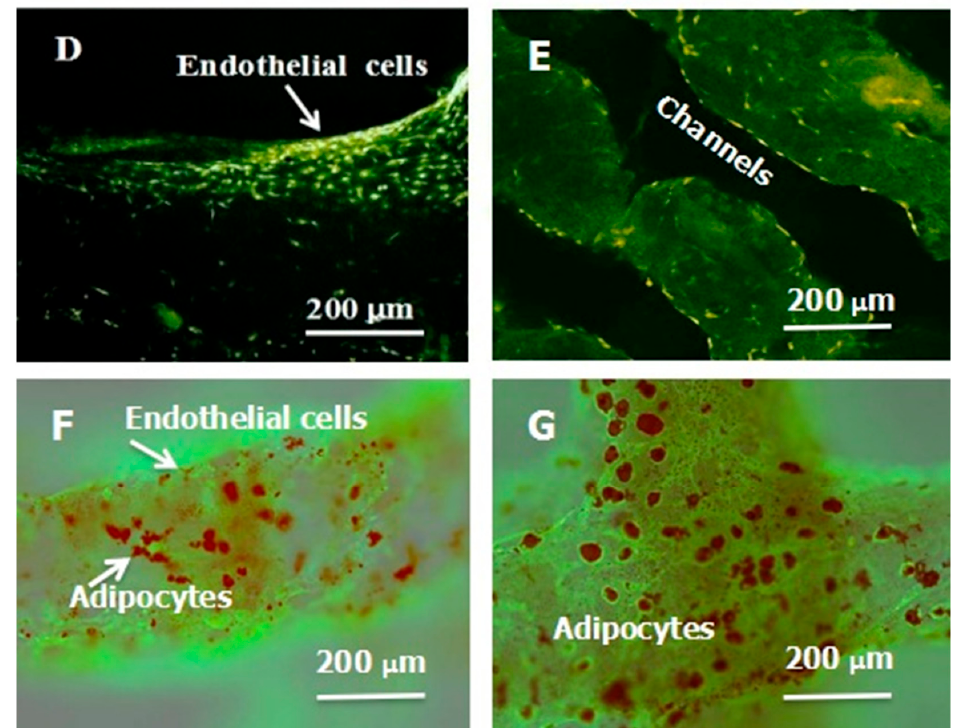
Figure 5. A large scale-up vascularized organ (i.e., vascularized adipose tissue incorporation with pancreatic islets) constructed through the double-nozzle gelatin-based hydrogel organ 3D bioprinting technology [27,28]: ( A ) the construction processes of the large scale-up vascularized organ (i.e., multicellular organ), based on the adipose derived stem cell (ADSC) laden gelatin/alginate/fibrin hydrogel 3D bioprinting and the subsequent β -cells (in the pancreatic islets) seeding procedures; ( B ) a multicellular construct, containing both ADSCs encapsulated in the gelatin/alginate/fibrin hydrogel before epidermal growth factor (EGF) engagement and pancreatic islet seeding in the predefined channels (immunostaining with anti-insulin in green); ( C ) immunostaining of the 3D construct with mAbs for CD31+ cells (i.e., mature endothelial cells from the ADSC differentiation after 3 days culture with EGF added in the culture medium) in green and pyrindine (PI) for cell nuclei (nucleus) in red; ( D ) immunostaining of the 3D construct with mAbs for CD31+ cells (i.e., mature endothelial cells) in green, having a fully confluent layer of endothelial cells (i.e., endothelium) on the surface of the predefined channels; ( E ) a vertical image of the 3D construct showing the fully confluent endothelium (i.e., endothelial cells) and the predefined go-through channels; ( F ) immunostaining of the 3D construct with mAbs for CD31+ cells in green and Oil red O staining for adipocytes in red, showing both the heterogeneous tissues coming from the ADSC differentiation after a cocktail growth factor engagement (i.e., on the surface of the channels the endothelium coming from the ADSCs differentiation after being treated with EGF for 3 days, deep inside the gelatin/alginate/fibrin hydrogel the adipose tissue coming from the ADSCs differentiation after being subsequently treated with insulin, dexamethasone and isobutylmethylxanthine (IBMX) for another 3 days. Spatial effect is prominent for the 3D printed constructs); ( G ) a control of ( F ), showing all the ADSCs in the 3D construct differentiated into target adipose tissue after 3 days treatment with insulin, dexamethasone and IBMX, but no EGF.